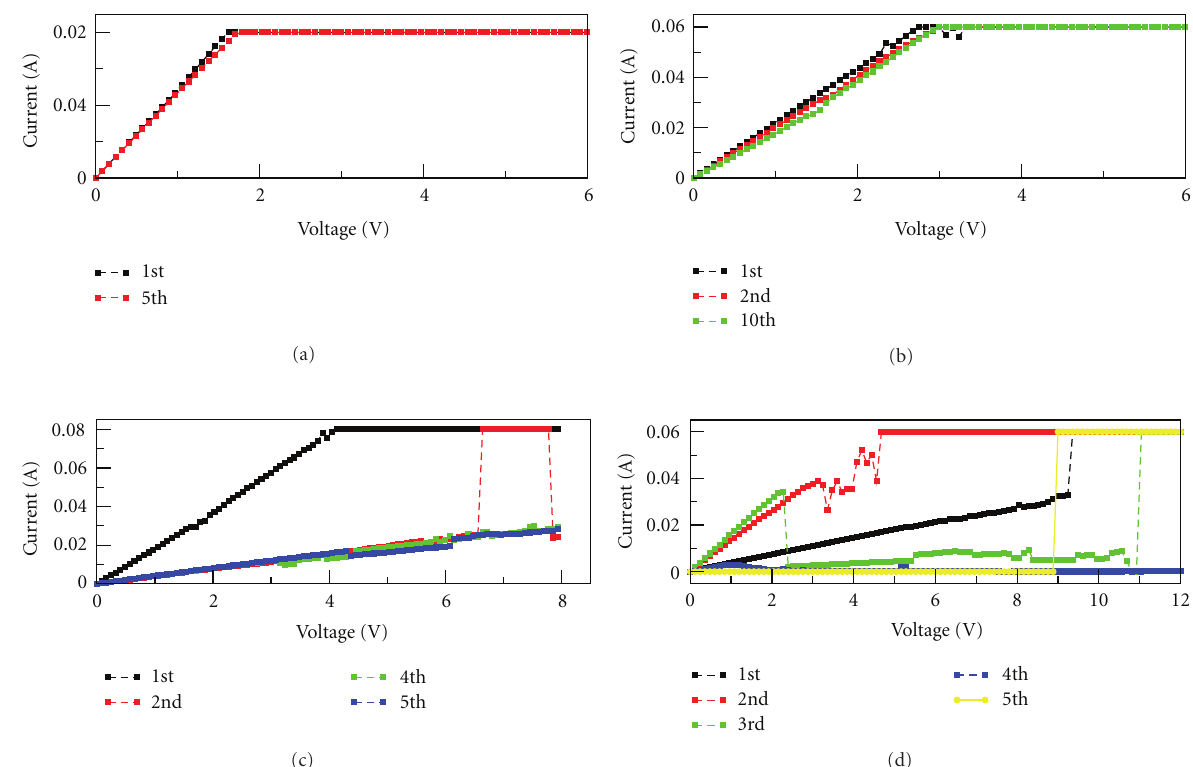
Figure 8: I-V behavior of a 17 nm PMMA device as a function of the compliance current. The electroforming of the device was realized using a compliance current of 20 mA, and the bias voltage was swept from 0 to 8 V. To study the e ff ect of the compliance current on the formation and rupture of filaments, these were set at (a) 40mA, (b) 60mA, (c) 80 mA, and (d) 60mA (see text). The I-V measurements were sequentially performed on the MIM